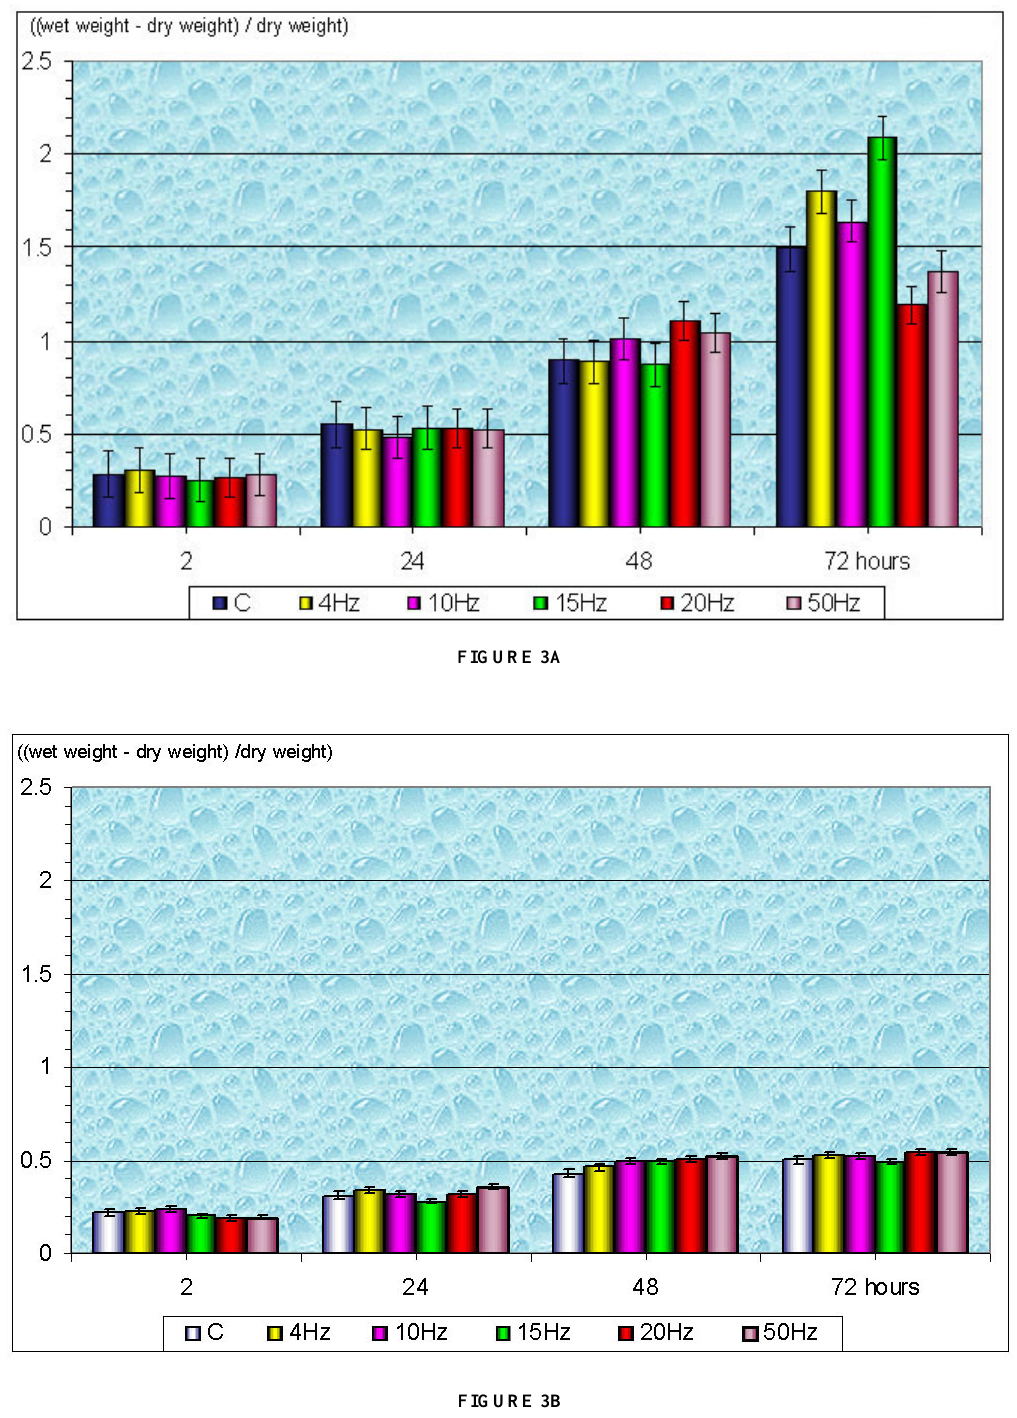
FIGURE 3. The effect of nontreated (control) and LF EMF-pretreated DW on seed hydration during 72-h incubation. (A) Seed hydration at room temperature (20 o C), (B) seed hydration in cold (4 o C) DW. On abscissa, the time (in hours) of seed incubation; on ordinates, value of seed hydration (mg of H 2 O for 1 mg of dry